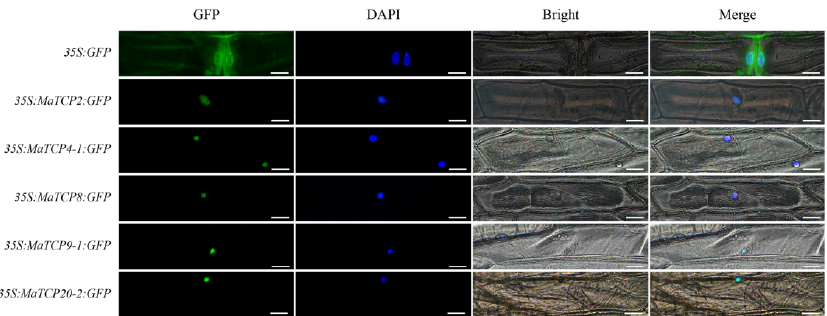
Figure 5. Subcellular localization of MaTCP2, MaTCP4-1, MaTCP8, MaTCP9-1, and MaTCP20-2 transcription factors. 35S:GFP is an empty vector control, and DAPI was used for nucleic acid staining. Scale bars, 50 μ m.